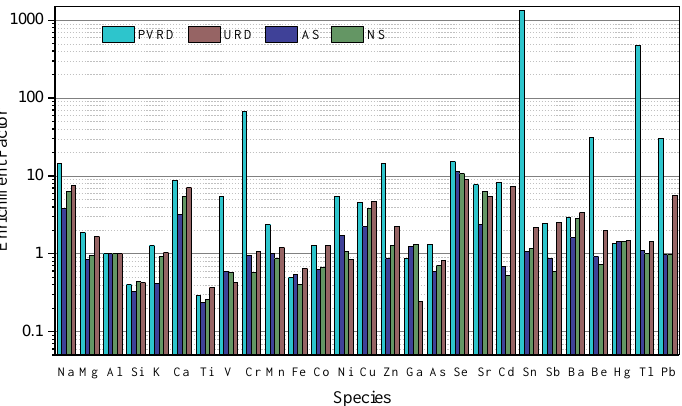
Figure 4. Elemental enrichment factors for geological sources of urban paved road dust (PVRD), urban resuspended dust (URD), agricultural soil (AS) and natural soil (NS) from southwestern regions of China. Al is used as reference.